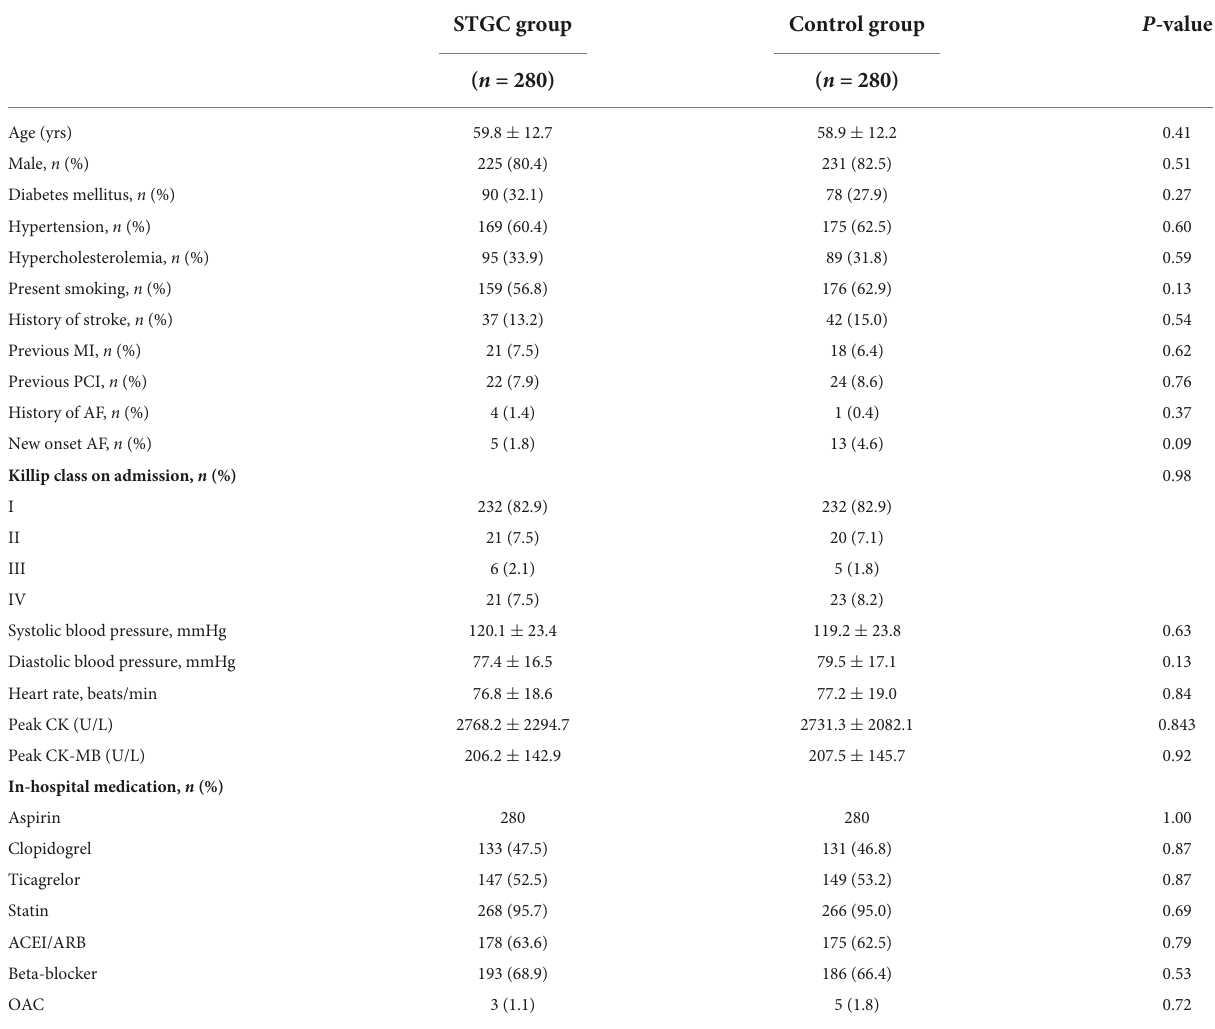
TABLE 1 Demographics and baseline